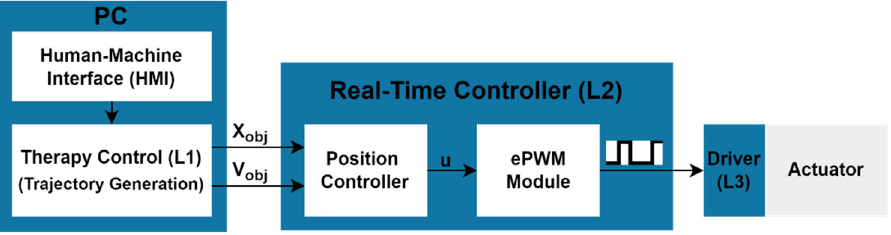
Figure 2. Control schema for the passive mode control.